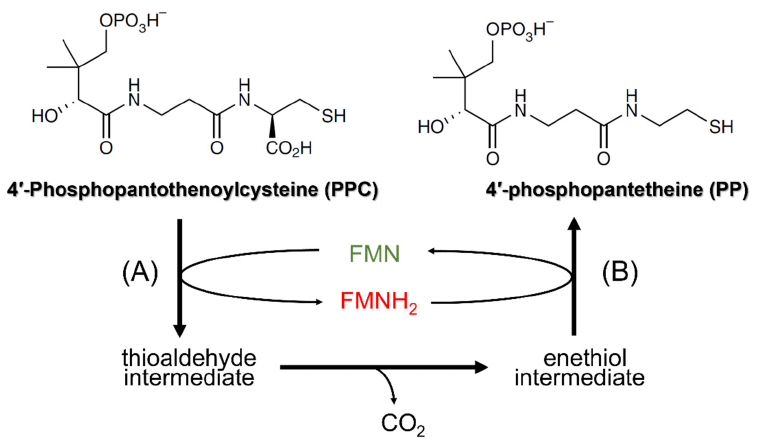
Figure 2. The reaction catalyzed by PPCDC. ( A ) denotes the flavin-dependent oxidation of PPC to the thioaldehyde intermediate, a reaction that requires the conserved histidine residue. After spontaneous decarboxylation of the intermediate, the conserved cysteine mediates the reduction of the enethiol to yield the final reaction product 4 ′ -phosphopantetheine ( B ), regenerating the oxidized flavin.